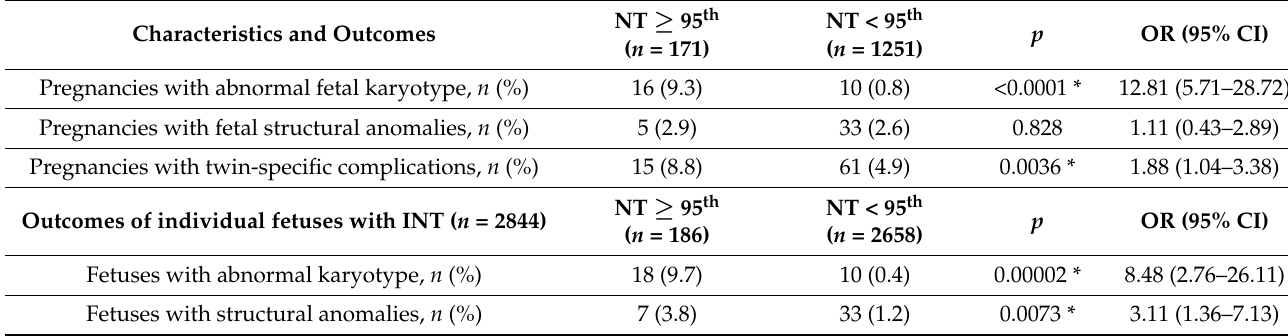
Table 4. Comparison of pregnancy outcomes in dc twin pregnancies and individual fetuses between increased NT ≥ 95 th and normal NT. ( n =